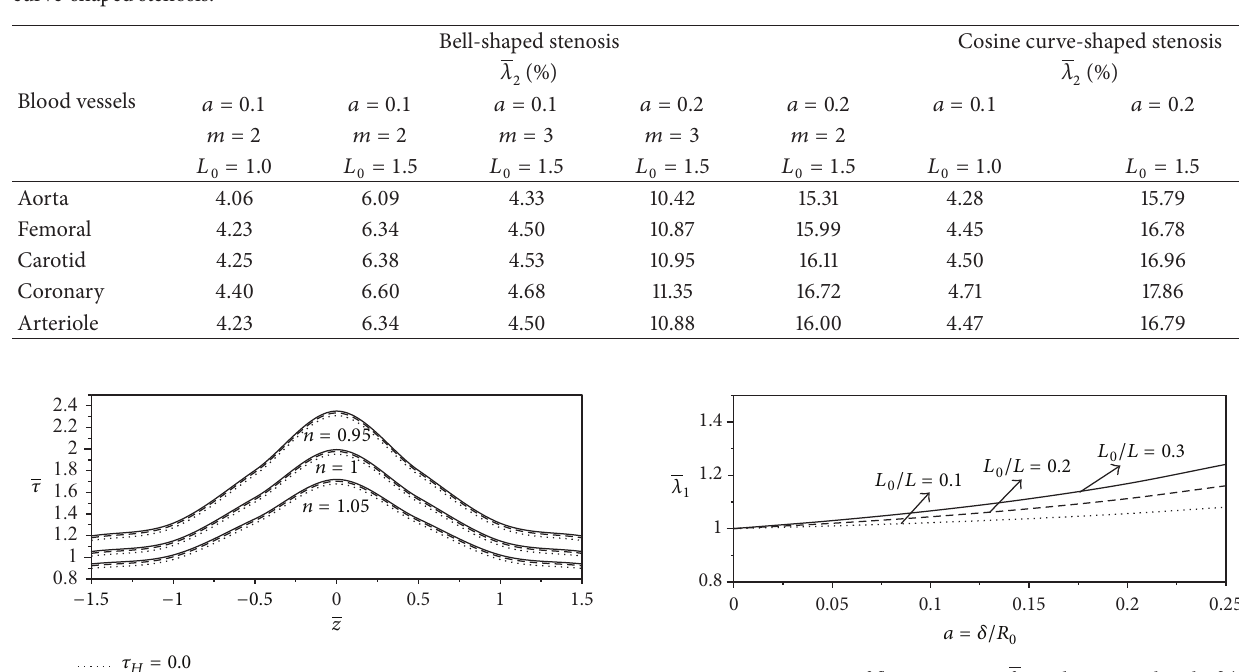
Figure 17: Variations of flow resistance 𝜆 1 with stenosis height 𝛿/𝑅 0 for different values of stenosis length 𝐿 0 /𝐿 .